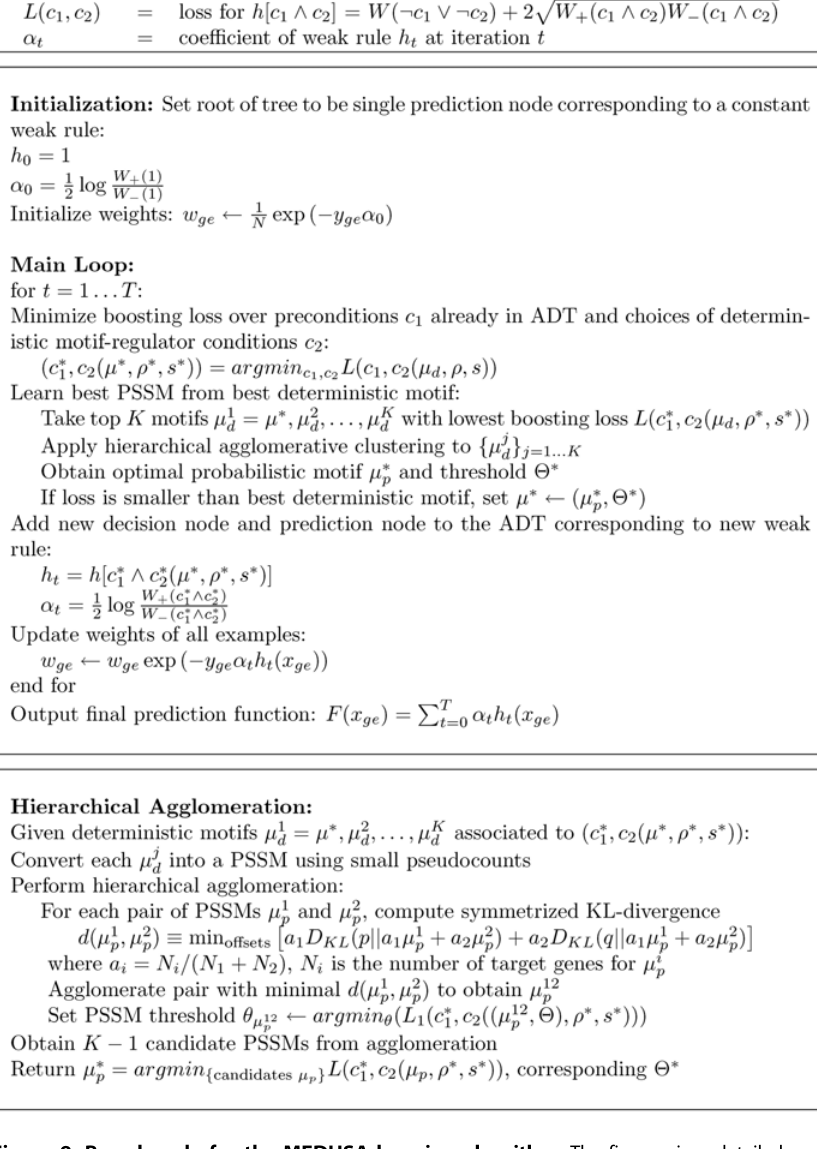
Figure 9. Pseudocode for the MEDUSA learning algorithm. The figure gives detailed pseudocode for the core MEDUSA algorithm which learns DNA motifs de novo from promoter sequences and assembles motifs and regulators into an alternating decision tree (ADT) for predicting up/ down regulation of target genes.